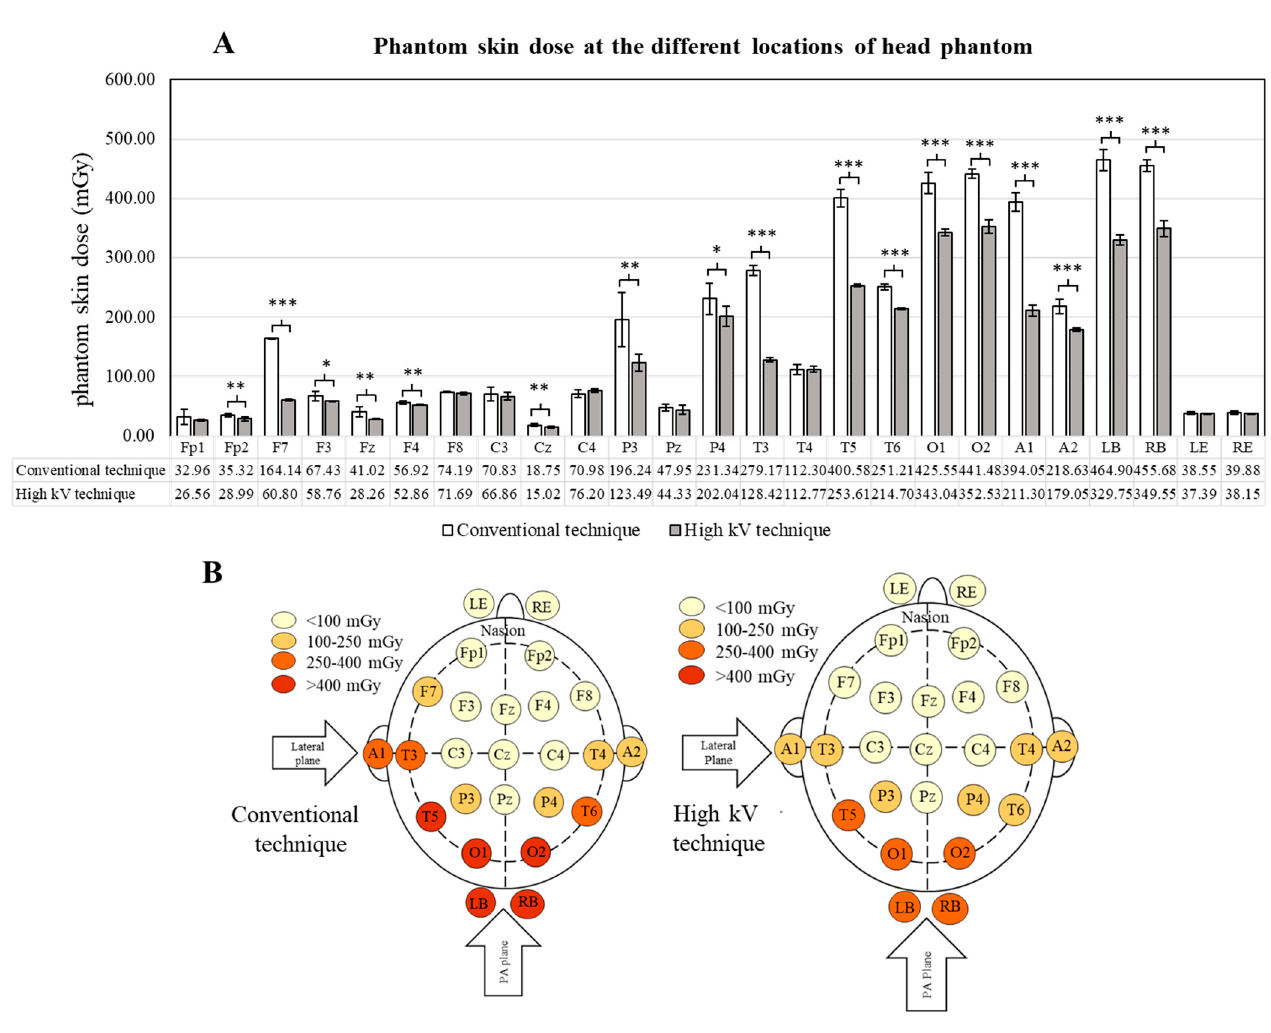
Figure 4. Phantom skin doses in different areas of the skull using the conventional and high kV techniques for the cerebral angiographic procedure: ( A ) bar graph demonstrates phantom skin doses, and ( B ) diagram demonstrates the distribution of radiation doses in different areas of the skull. *, **, and *** indicate a significant difference in radiation dose between the conventional and high kV techniques with p -value < 0.05, 0.01, and 0.001, respectively. The data on skin dose are presented as mean, while the bar graph presents the mean ± SD. A = auricle, C = central, F = frontal, Fp = prefrontal, LE = left eye, LB = back of neck on left side, O = occipital, P = parietal, RB = back of neck on right side, RE = right eye, T = temporal, and z = midline sagittal plane. Table 3. The radiation dose report, including the DAP and RAK of the 2DA, 3DRA, and fluoroscopy, the total DAP, and the total RAK, from the phantom study.